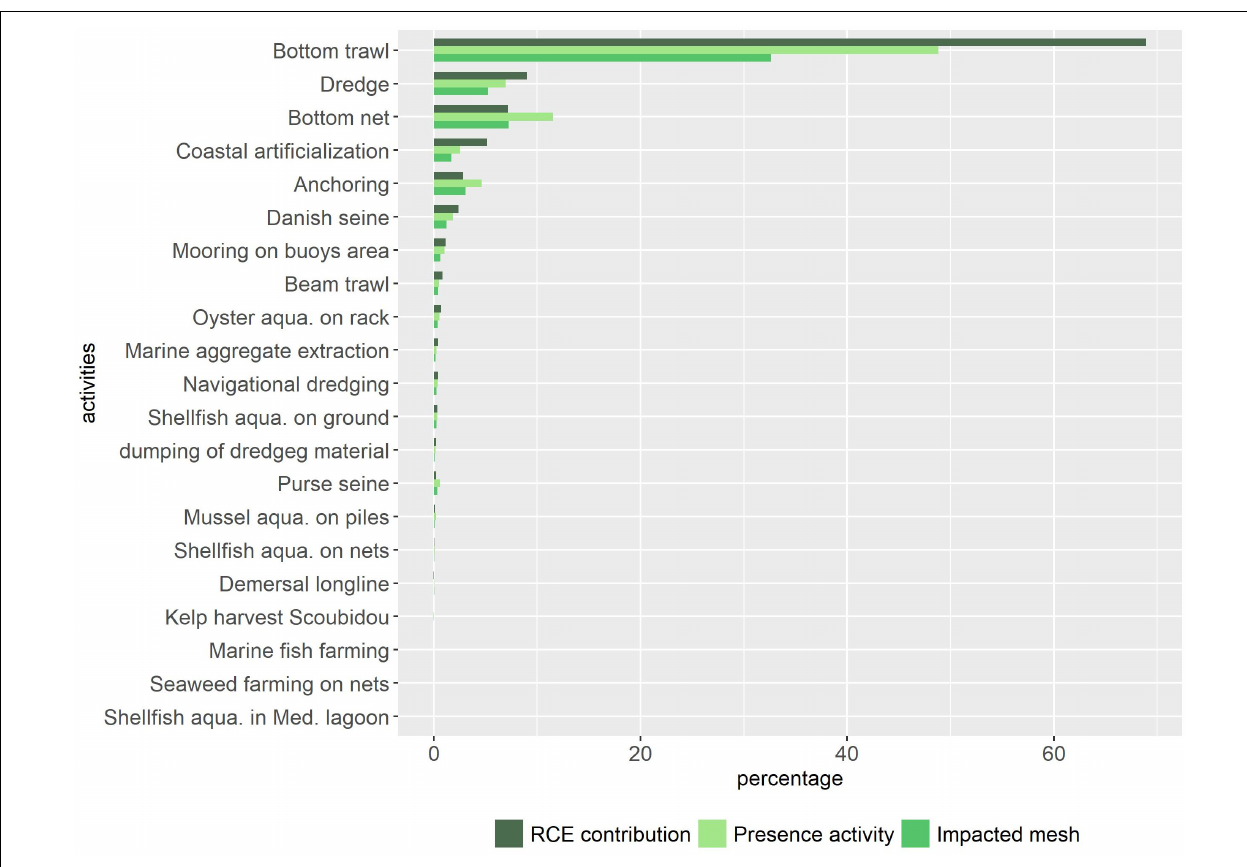
FIGURE 7 | Contribution of human activities to the RCE. “Activity presence” represent the percentage of grid cells where the activity is located; “impacted mesh” represents the percentage of grid cells were the activity contributes to the RCE; “contribution to RCE” represents the contribution of the activity to the total RCE in the studied area, in